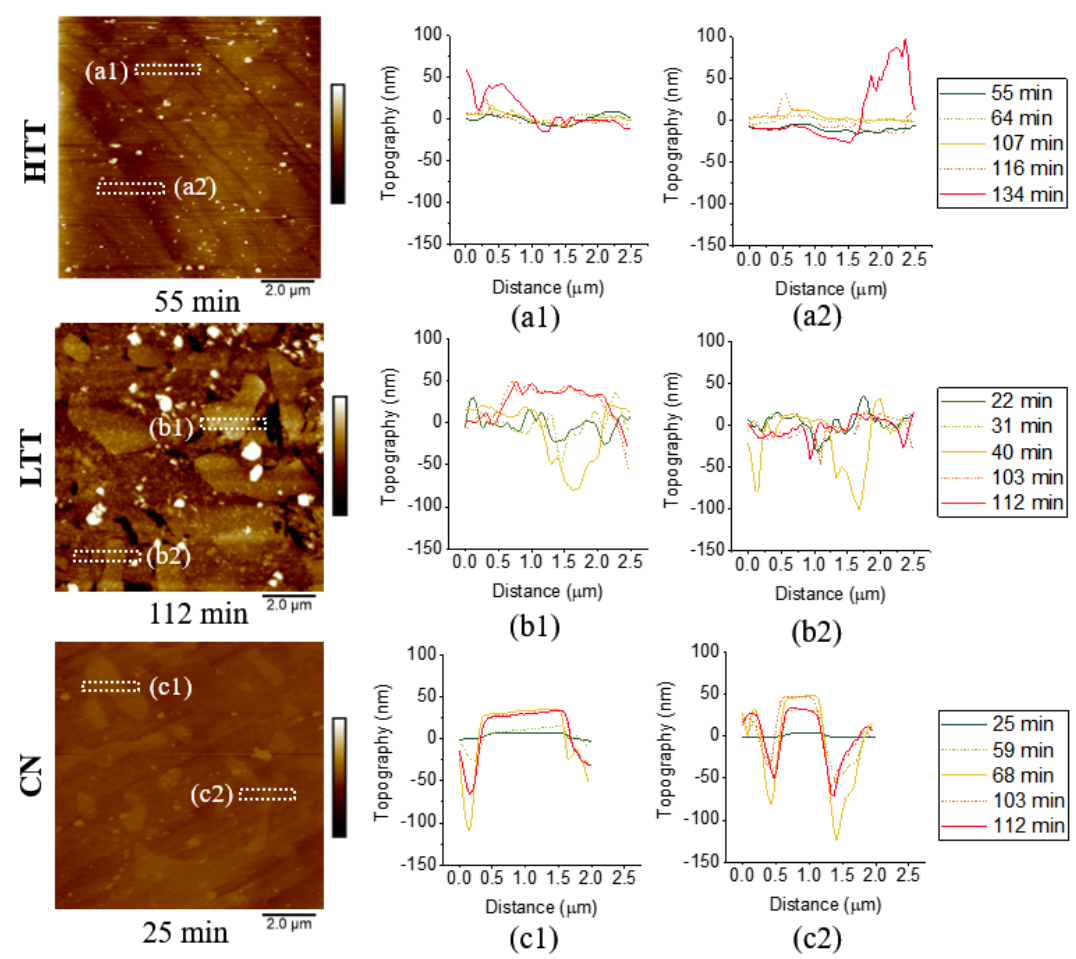
Figure 9. Topography maps (( a , b , c) , 160 nm full scale, exposure time indicated below corresponding map) for each of the three heat-treated MSSs with height profiles across selected carbide-matrix interfaces shown as a function of exposure time to 0.1M NaCl solution ( a1 – c2 ). Location of each profile is indicated by the corresponding box in the exemplary topography maps presented at left for each of the three heat-treated